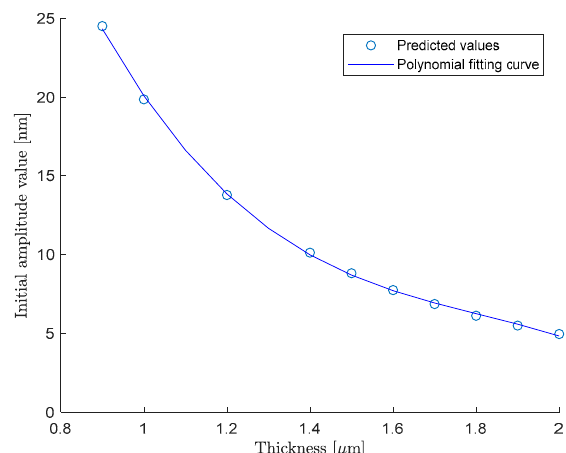
Figure 5. The influence of beam thickness on the decrease in the initial value of the amplitude.